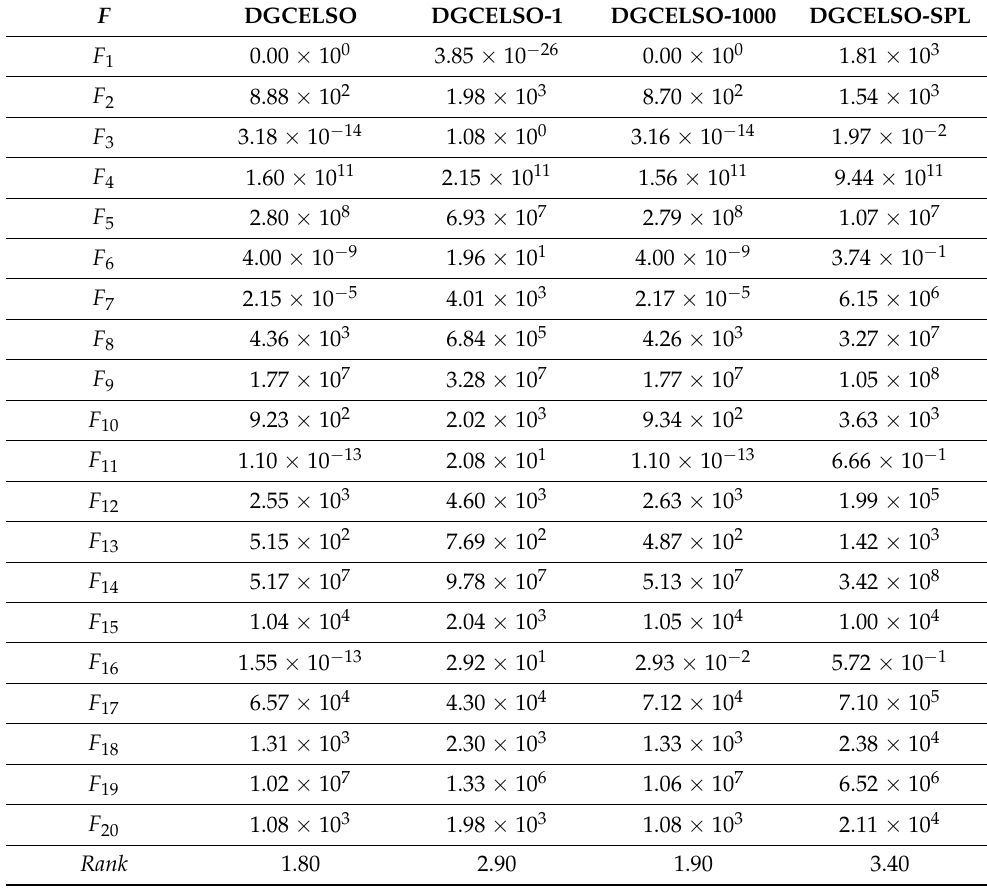
Table 5. Comparison results among different versions of DGCELSO on the 1000-D CEC’2010